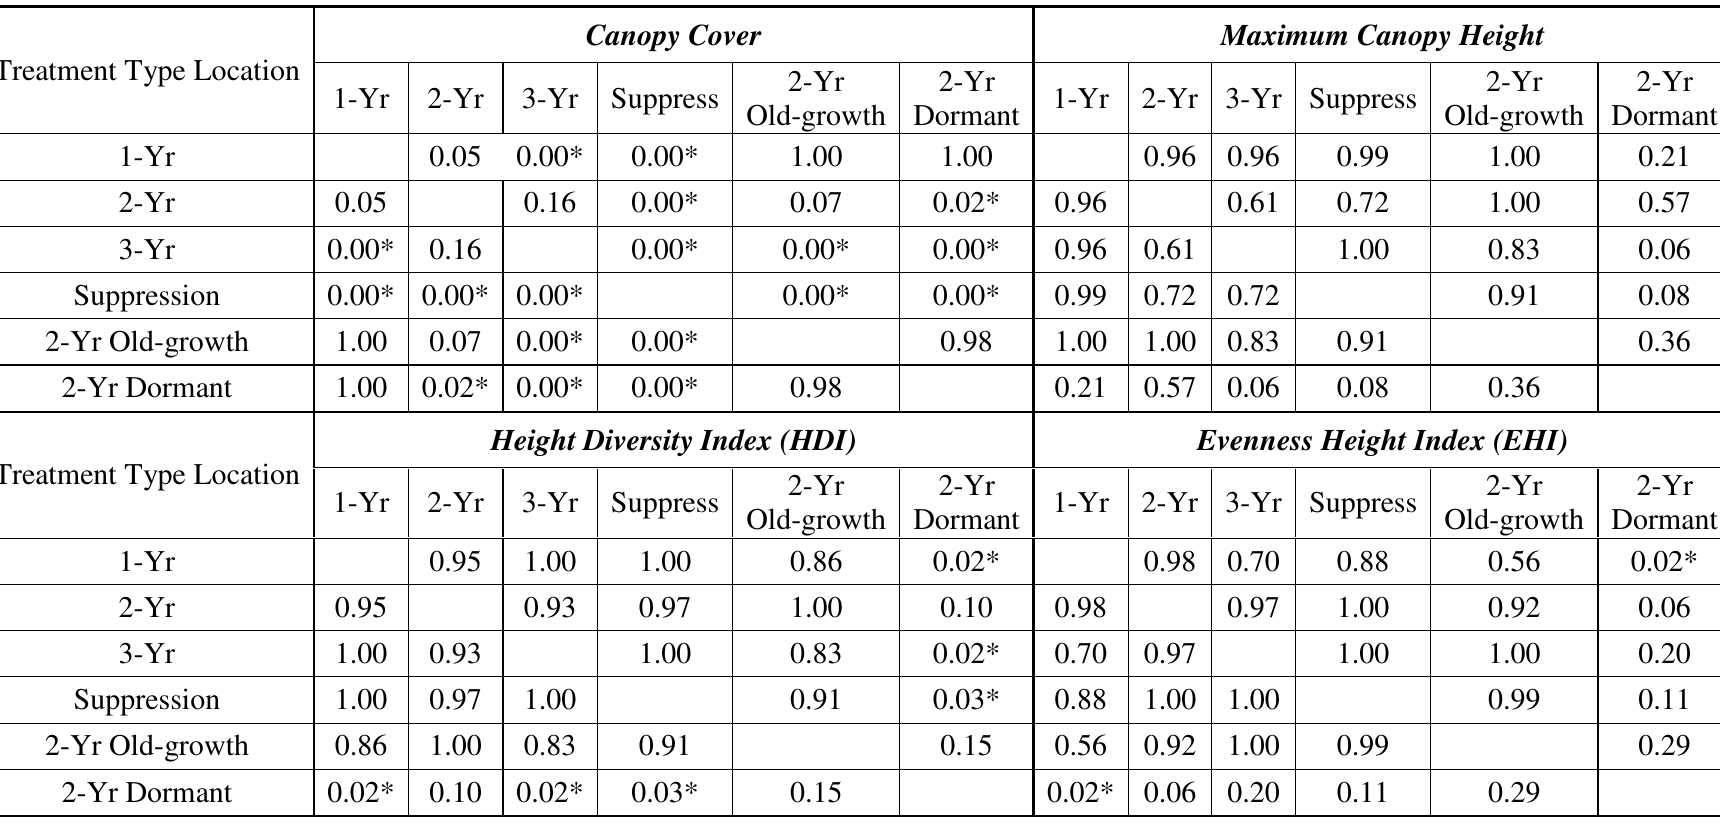
Table 3. Post-hoc Tukey HSD probability results for the structural variables (canopy cover, maximum canopy height, height diversity index, and evenness height index) derived from the portable LiDAR dataset among fire